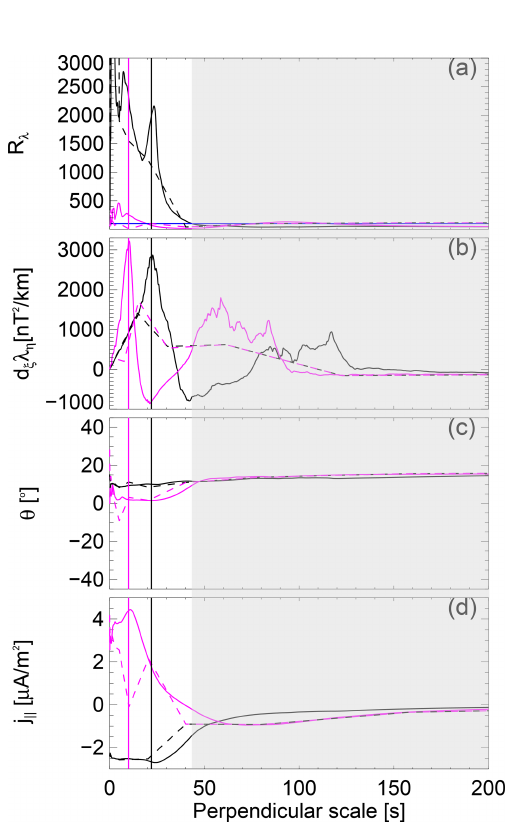
Figure 6. Sections in the MSMVA scalograms showing the depen- dence of the parameters as a function of the perpendicular scale (scale corrected). (a) R λ ; (b) ∂ ξ λ η ; (c) θ ; (d) j (cid:107) . Solid/dashed lines indicate the profiles for the linear-/logarithmic-scale sampling scheme. The profiles are taken in the middle of the upward and downward FACs located at 03:24:43 and 03:25:00, respectively. These times are indicated by the vertical solid lines in Fig. 5 (same color code). The vertical black/magenta lines indicate the scales of these FAC elements as identified by ∂ ξ λ η . The horizontal blue line in (a) indicates a reference level, R λ = 100, discussed in the text. The marked gray area indicates the region where R λ < 100 for the selected sections.